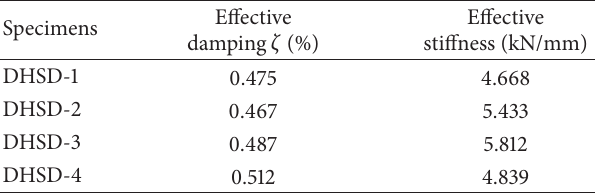
Table 4: Effective damping and stiffness at maximum displacement.